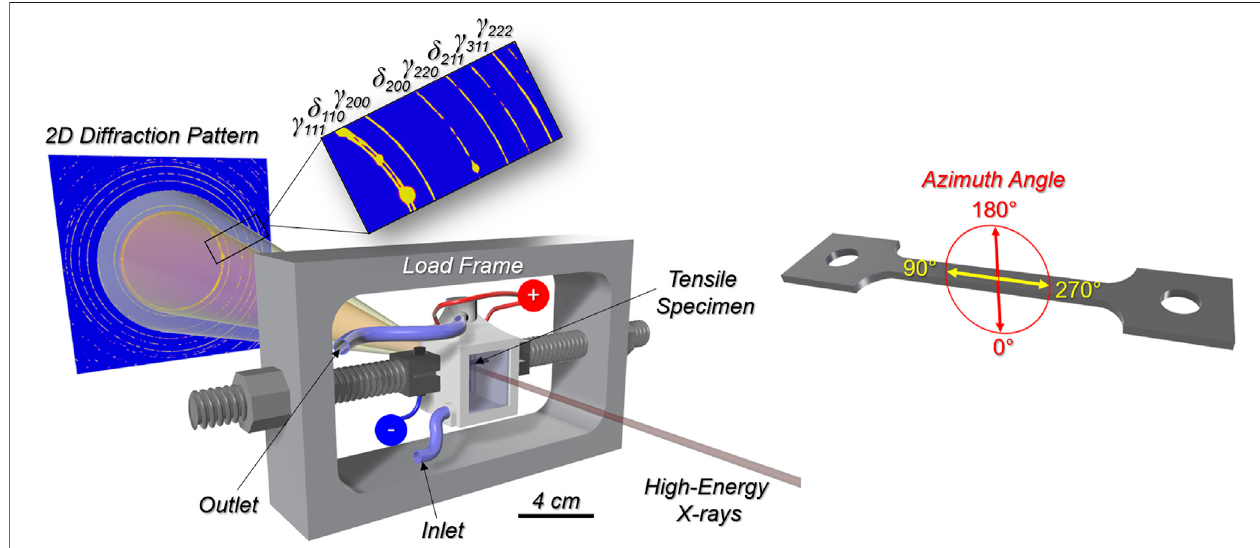
FIGURE 1 | Schematic showing the experimental setup for in-situ time- and space-resolved lattice strain measurements using synchrotron high-energy x-ray diffraction. The angles on the tensile specimen indicate the azimuth directions for the strain information.